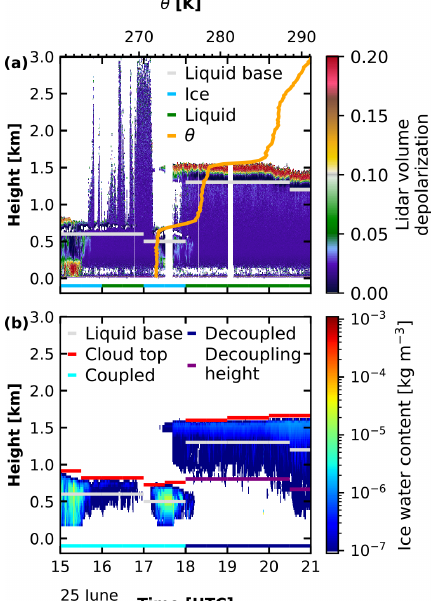
Figure 3. An example of the applied method on 25 June 2017 be- tween 15:00–21:00UTC. In (a) the lidar volume depolarization is shown. Marked are also flags for liquid layer base height (gray) and cloud phase (ice: blue; liquid: green). Additionally the θ profile for the sounding launched at 17:15UTC (orange) is plotted. In (b) the cloud radar reflectivity is depicted together with information on the liquid base height (gray), cloud top height (red), the coupling state (cyan: coupled; dark blue: decoupled), and (if applicable) the de- coupling height